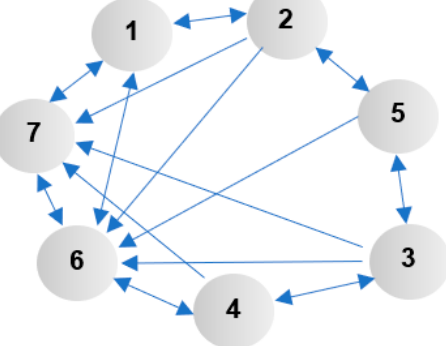
Figure 2. The graph of transition.